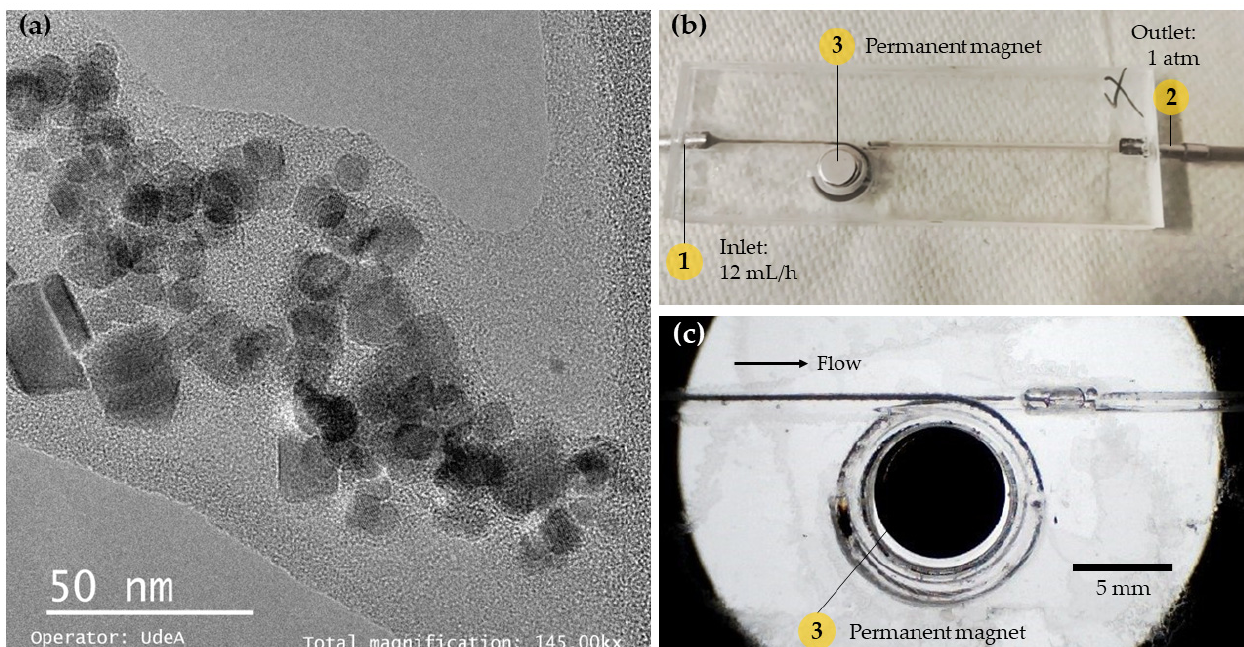
Figure 8. ( a ) Transmission electron microscopy micrograph of magnetite nanoparticles. ( b ) Picture of the one-loop microreactor during Eriochrome Black T dye treatment. ( c ) Picture of the one-loop microreactor during Eriochrome Black T dye treatment under optical microscope (10X magnifica- tion).